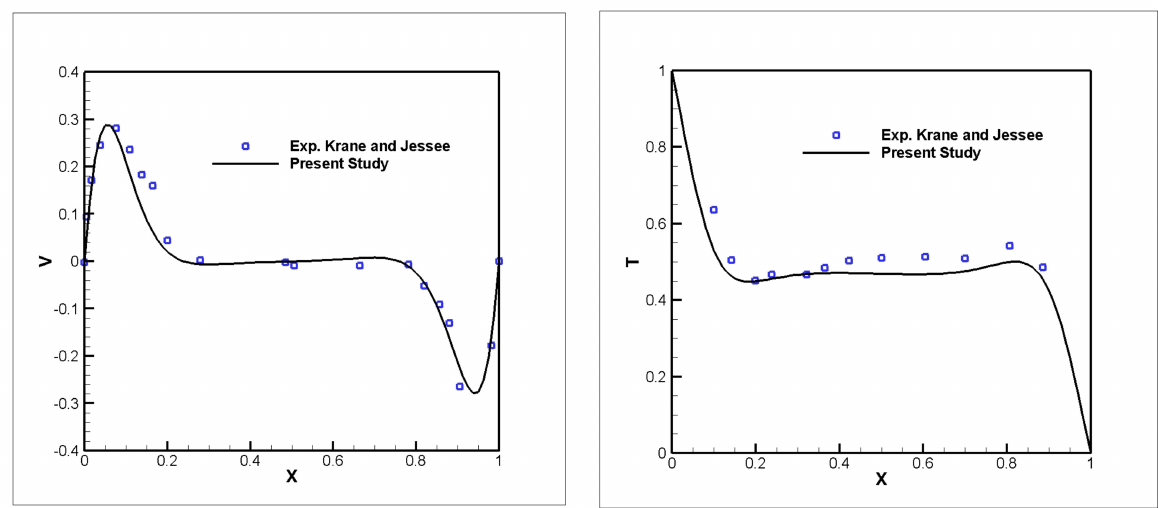
Figure 2. Comparison of temperature and vertical velocity profile between the present results and the experimental results by Krane and Jessee [29] ( Ra = 1.89 × 10 5